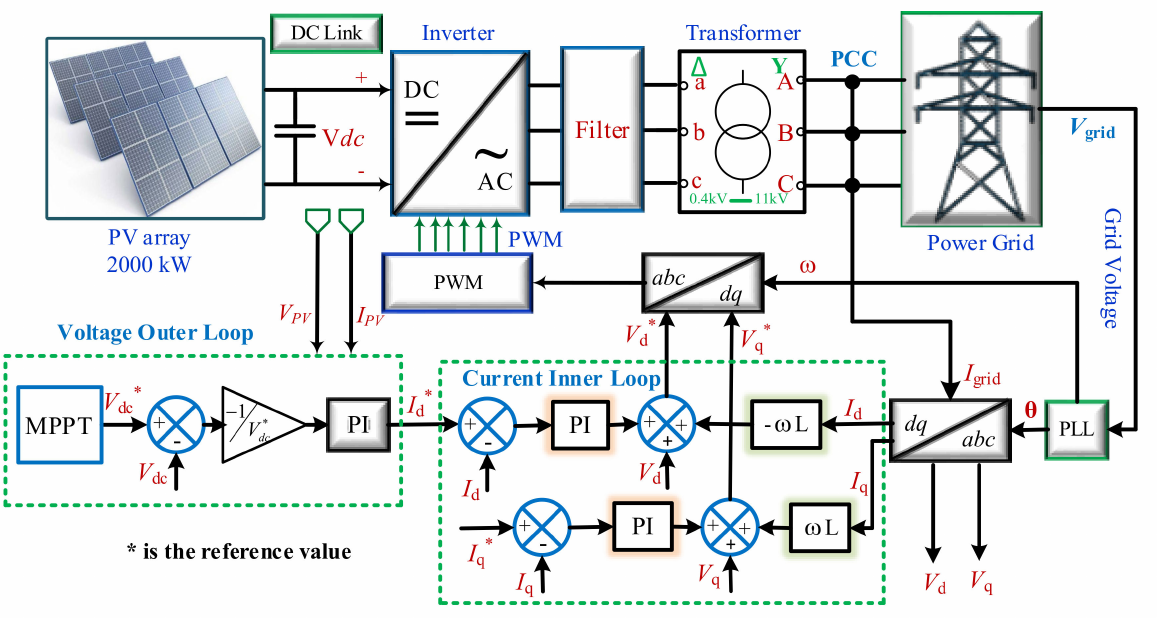
Figure 2. Large-scale PV power station interconnected to the utility